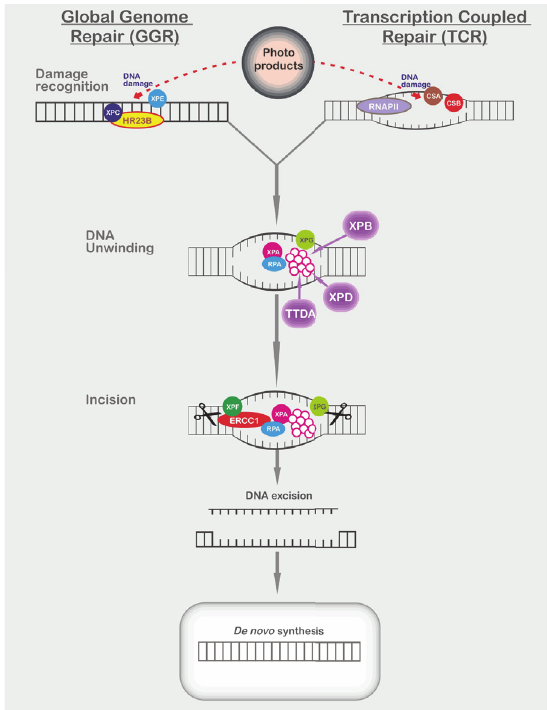
Figure 1: Nucleotide excision repair (NER) pathway. Transcription coupled repair (TCR) removes DNA damage from actively transcribed genes and global genome repair (GGR) from the rest of the genome [13]. TCR starts when RNA polymerase stops at the damaged DNA, which acts as a signal for CSA and CSB binding. In GGR, the XPE protein and the XPC-HR23B complex recognize the DNA damage. Upon initial recognition of the DNA lesion, both pathways converge. The XP-B and XP-D DNA helicases unwind the region surrounding the damaged site, along with the XP-A, XP-G, and replication protein A (RPA) [14]. The XPF-ERCC1 nuclease complex and XP-G endonuclease excise the damaged DNA. The resulting gap is replaced by de novo DNA